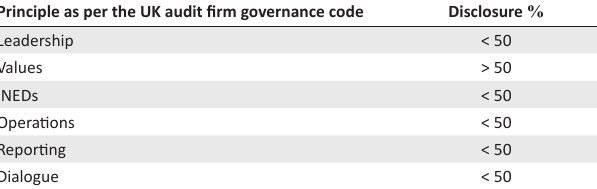
TABLE 8 : Summary of findings.